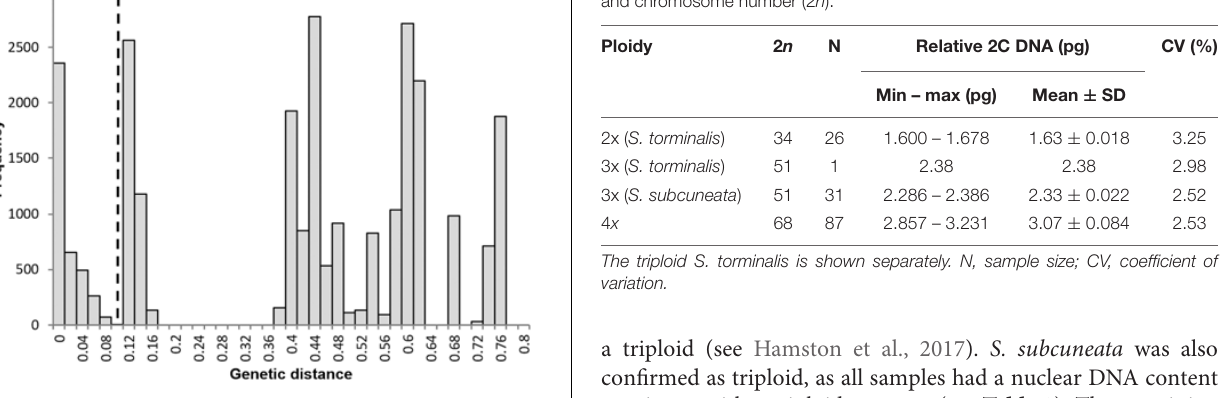
FIGURE 5 | Frequency distribution of pairwise genetic distances between all polyploid individuals. N = 160. No. of pairwise comparisons = 25,600. The dashed line represents the threshold distance applied to separate asexually and sexually related individuals = 0.09.